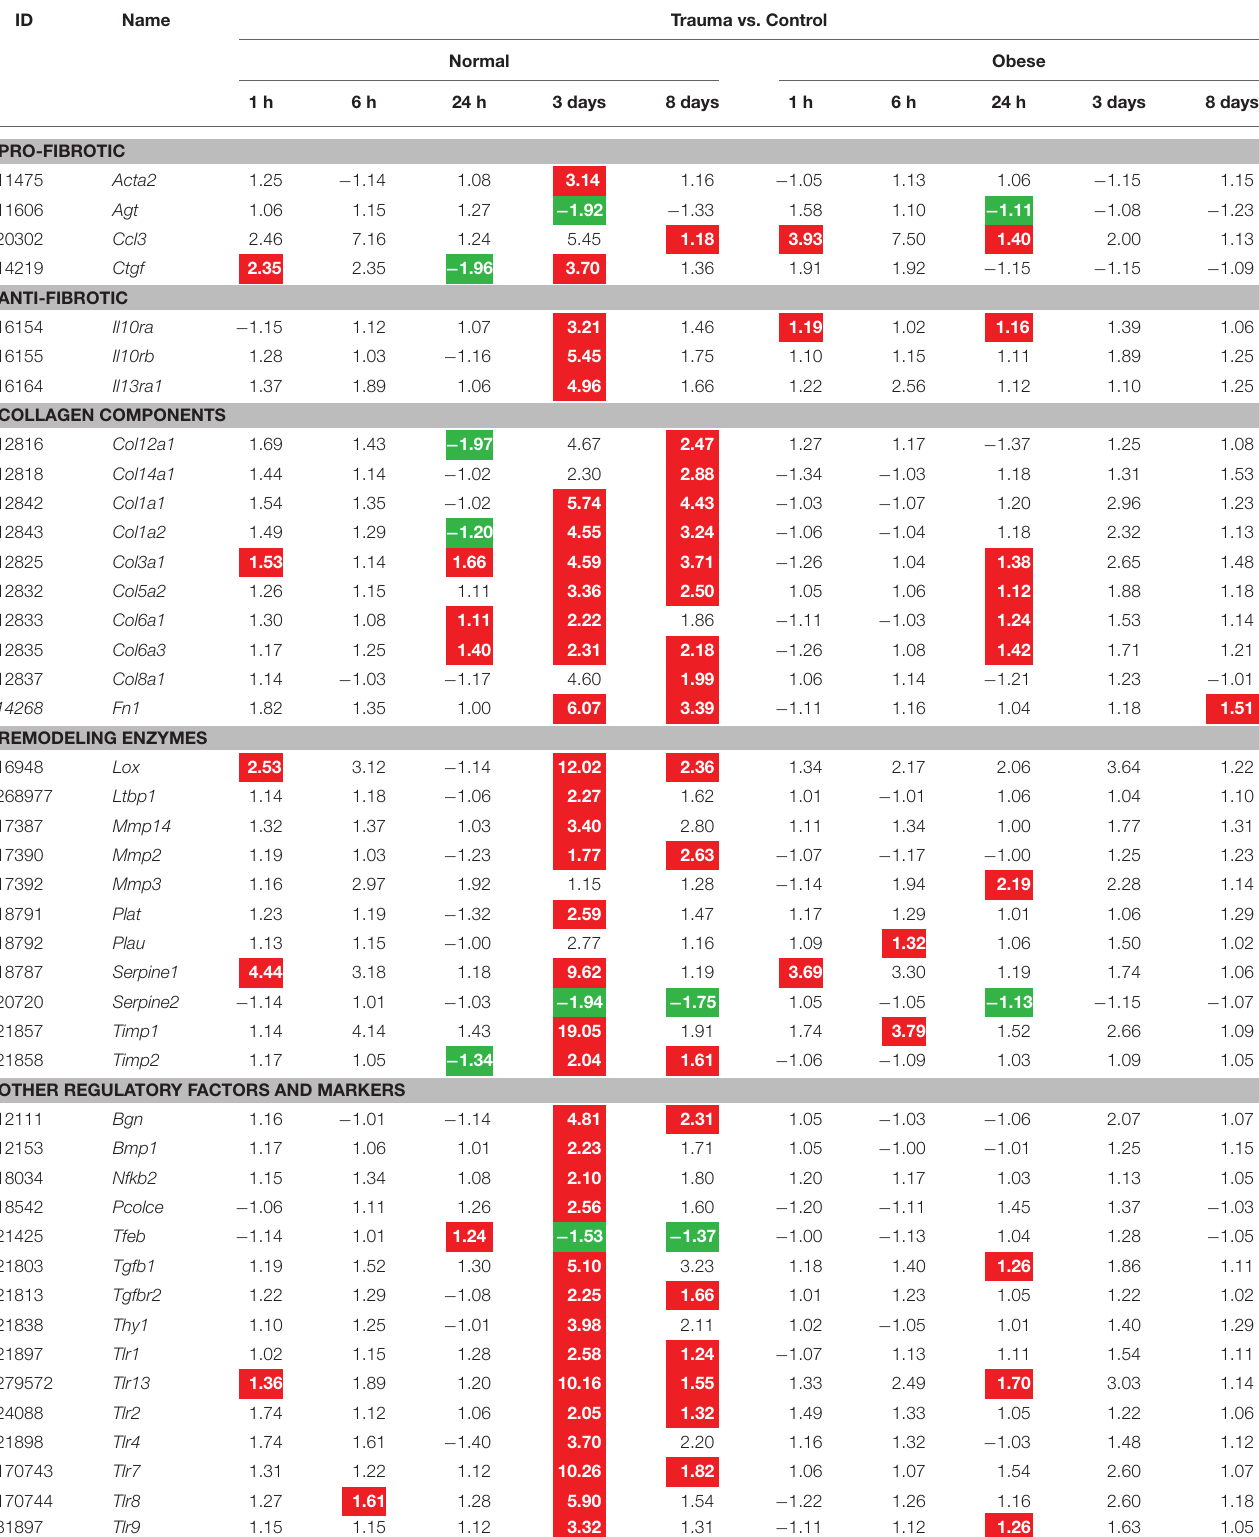
TABLE 2 | Gene expression levels in fold change values determined by microarray analysis for fibrosis formation.